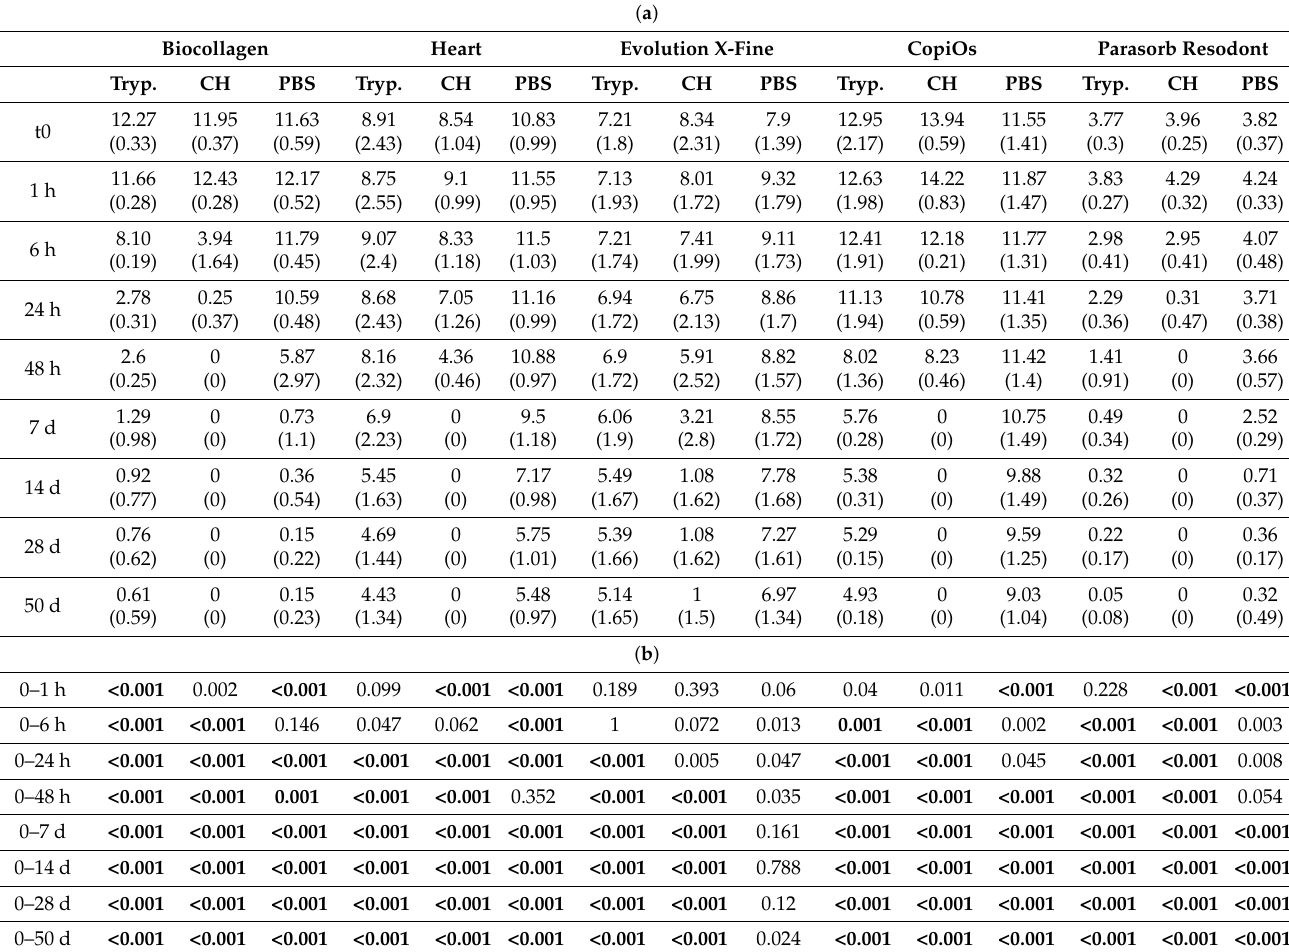
Table 3. ( a ) Weight values (g) of the five membranes (Biocollagen, Heart, Evolution X-fine, CopiOs and Parasorb Resodont) after being submitted to PBS, trypsin and C. histolyticum for 1 h to 50 d. Values are presented as means and standard deviations. ( b ) Obtained p values after pairwise comparisons between membrane weights before immersion (initial weight or weight at t0: W0) and after the different immersion periods. Significance was considered at p < 0.001. ( a ) Biocollagen Heart Evolution X-Fine CopiOs Parasorb